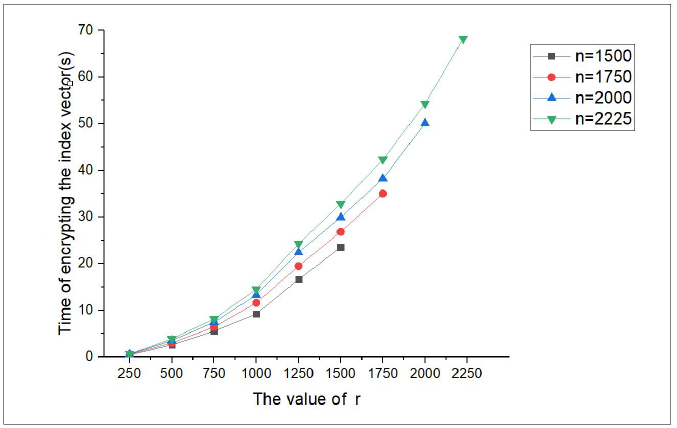
Figure 6. Time for doing the